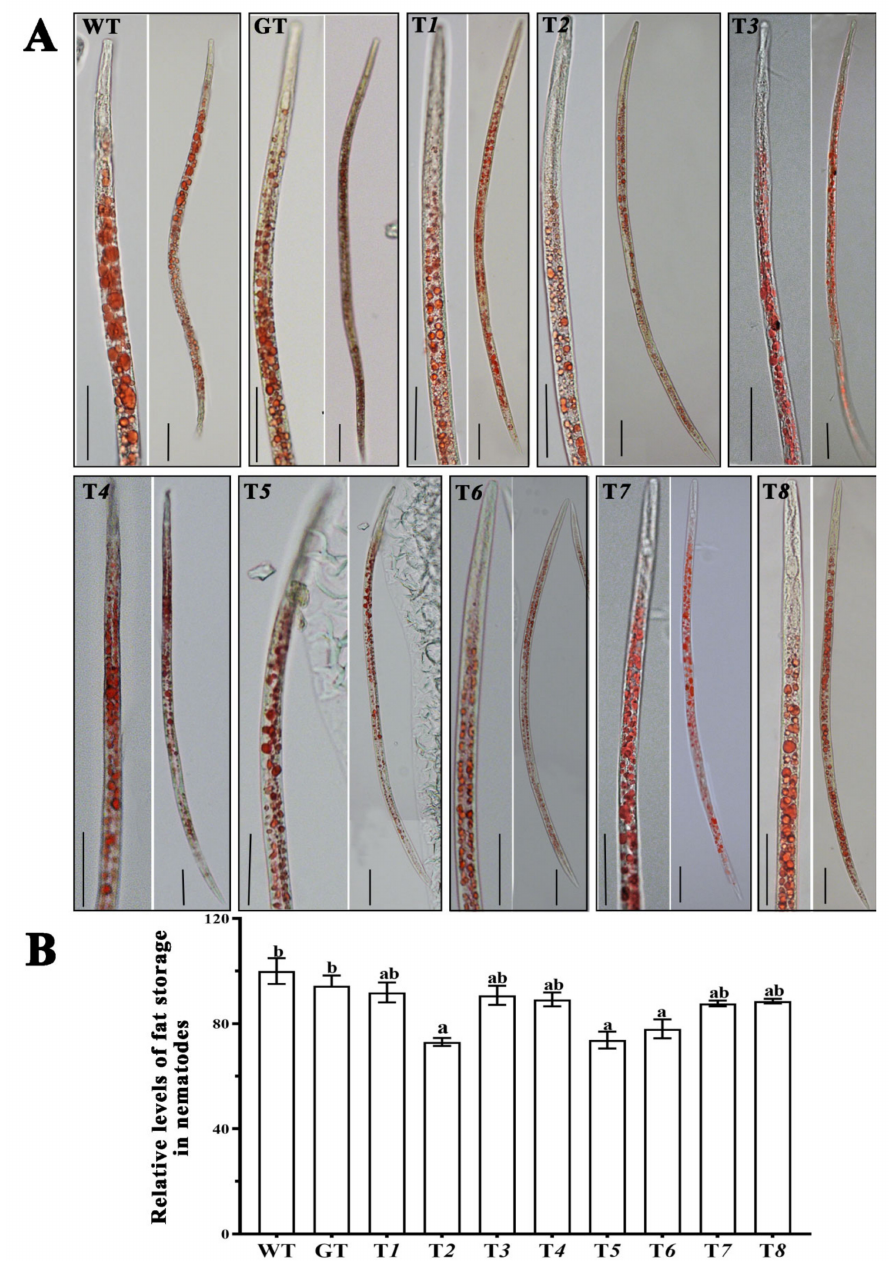
Figure 5. Fat storage of Aphelenchoides besseyi fed Ab-far-n hpRNA transgenic Botrytis cinerea . ( A ) Oil red O staining of A. besseyi cultured with transgenic B. cinerea . ( B ) The relative levels of fat storage in A. besseyi cultured with transgenic B. cinerea . WT, nematodes cultured on wild-type B. cinerea ; GT, Nematodes cultured on eGFP hpRNA transgenic B. cinerea ; T 1 -T 8 , nematodes cultured on either Ab- far-1 — Ab-far-8 hpRNA transgenic B. cinerea , respectively. Bar = 50 µ m. Values are means ± standard error, n = 10. Different lowercase letters denote values that are significantly different from each other ( p < 0.05; Tukey’s